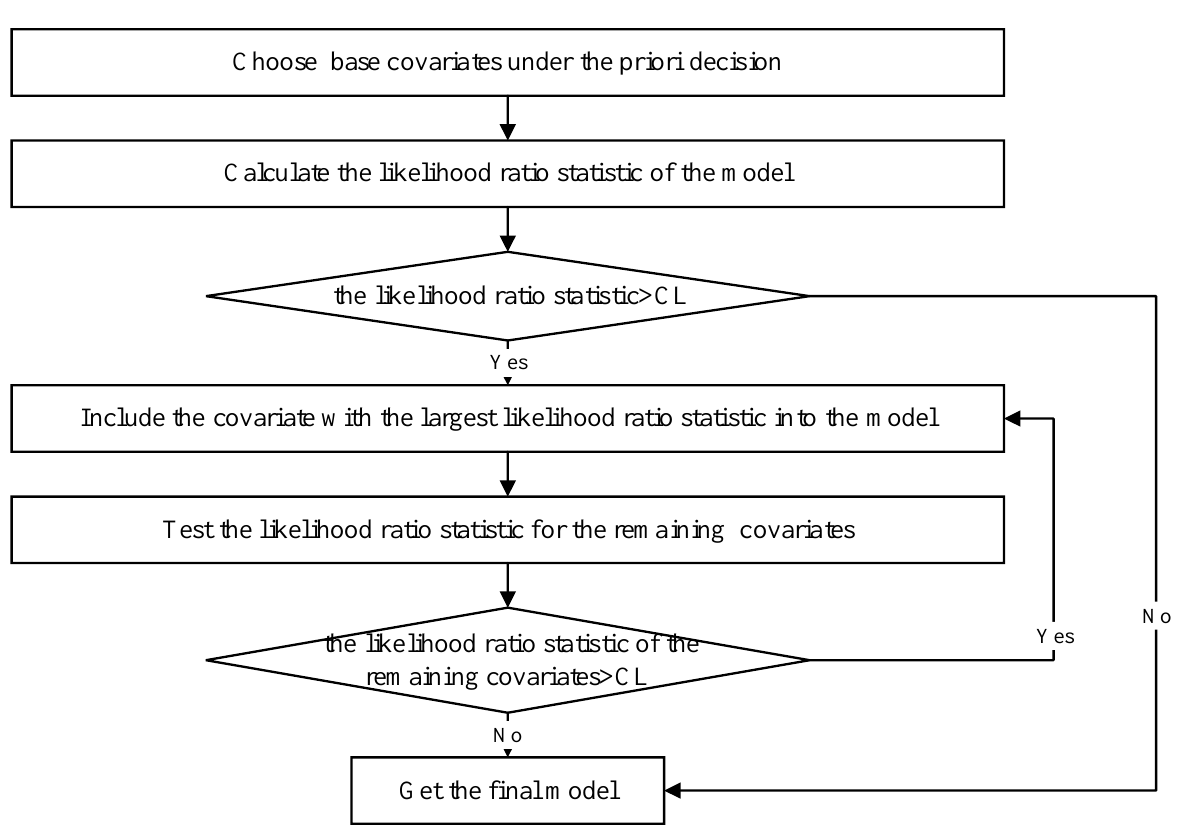
Figure 1. The process of covariate selection.